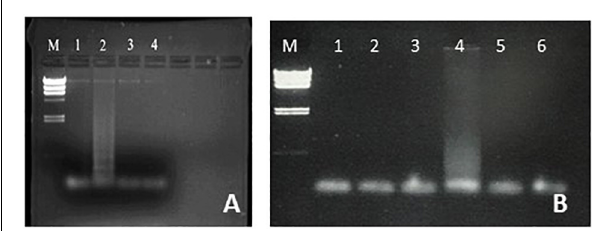
FIGURE 2 | Optimization of S. aureus LAMP amplification. (A) Optimization of LAMP targeting the femA gene. Lane M, lambda Hin dIII marker. Reactions carried out at 55 ◦ C (lane 1), 60 ◦ C (lane 2), 65 ◦ C (lane 3), and 70 ◦ C (lane 4). (B) Optimization of LAMP targeting the nuc gene. Lane M, lambda Hin dIII marker. Lanes 2, 4, and 6 have S. aureus template and lanes 1, 3 and 5 are negative controls with water in place of template. Lanes 1, 2: 57 ◦ C. Lanes 3, 4: 62 ◦ C. Lanes 5, 6: 67 ◦ C.